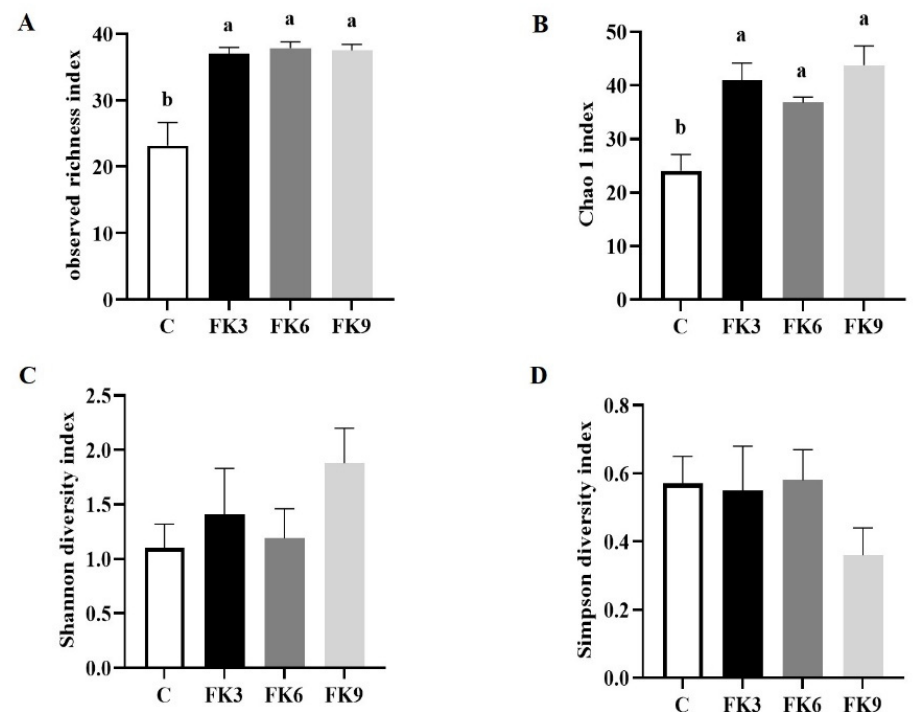
Figure 5. The alpha diversity of microbiota in the distal intestinal of largemouth bass fed diets with various FK levels. ( A ) Observed richness; ( B ) Chao index; ( C ) Shannon index; ( D ) Simpson index. Graph bars labelled with different letters “a” or “b” on top indicate significant results, whereas bars with the same letter correspond to results that show no significant differences among groups ( p < 0.05, means ± SEM, n = 6).